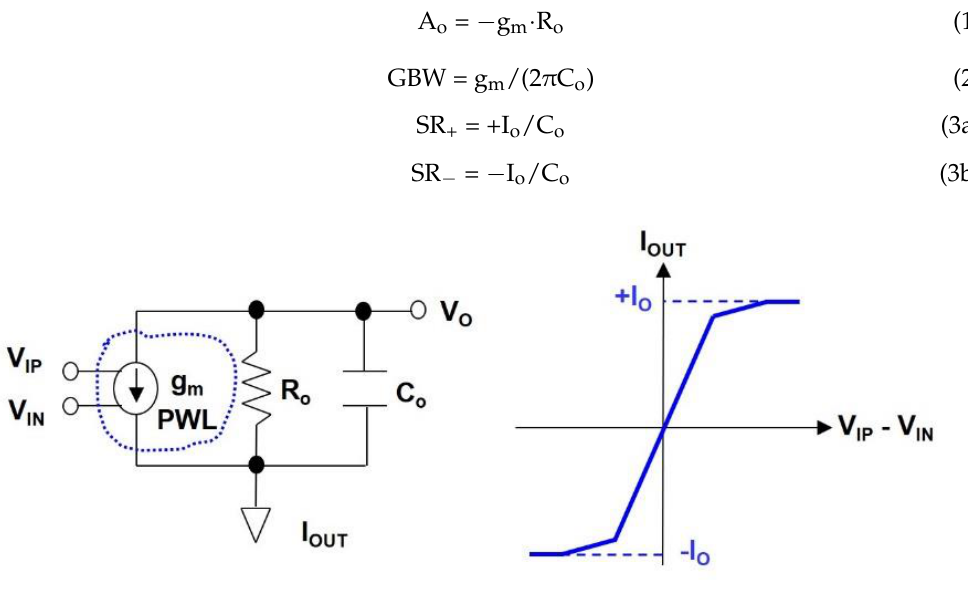
Figure 2. Concept of amplifier macro model.